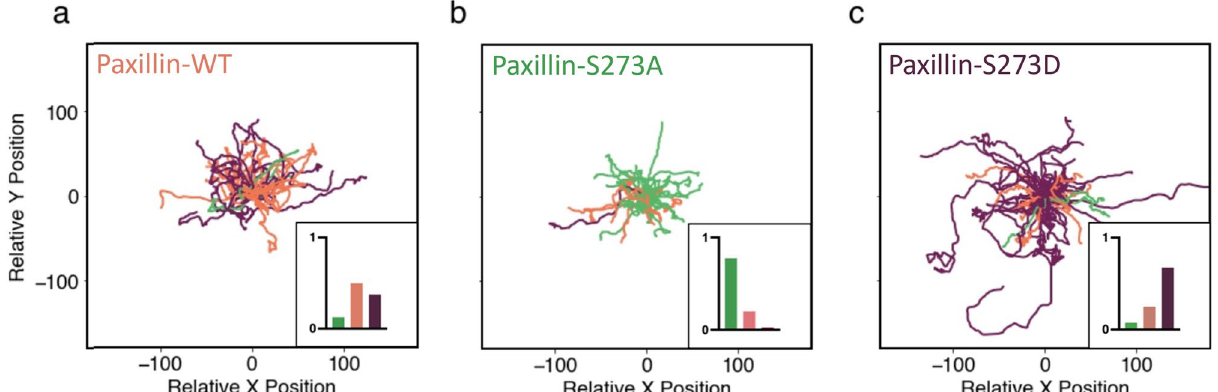
Figure 8. Machine classification of CHO-K1 cell tracks in three different condition. Classification of tracks of 40 CHO-K1 cells expressing ( a ) paxillin-WT-EGFP , ( b ) paxillin-S273A-EGFP, or ( c ) paxillin-S273D-EGFP mutant. Trajectories were colour-coded based on the classifier’s predictions with orange corresponding to tracks classified as cells expressing WT paxillin, green the S273A mutant, and purple as the S273D mutant. Insets: bar charts showing the distributions of the classifier’s predictions within each class. Same tracking data from Rajah (2020) 40 as in Fig. 6 were used to produce the